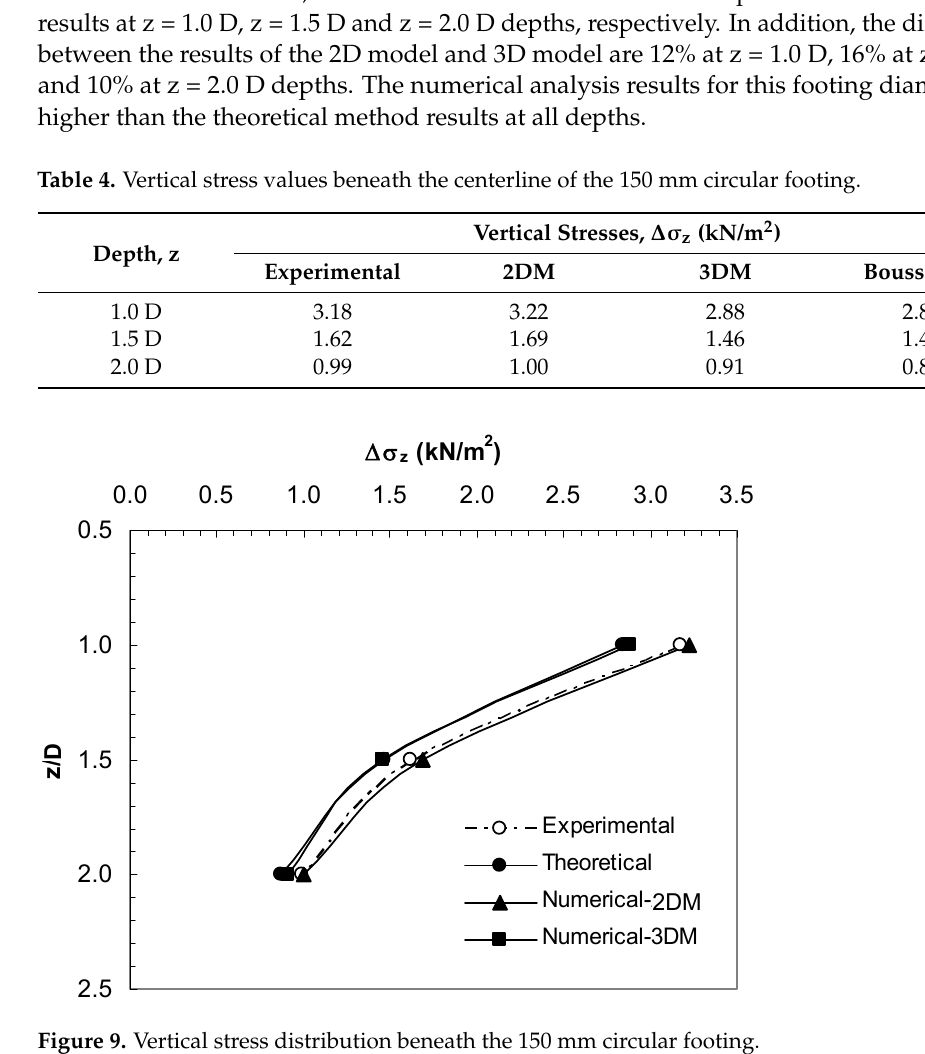
Figure 9. Vertical stress distribution beneath the 150 mm circular footing.